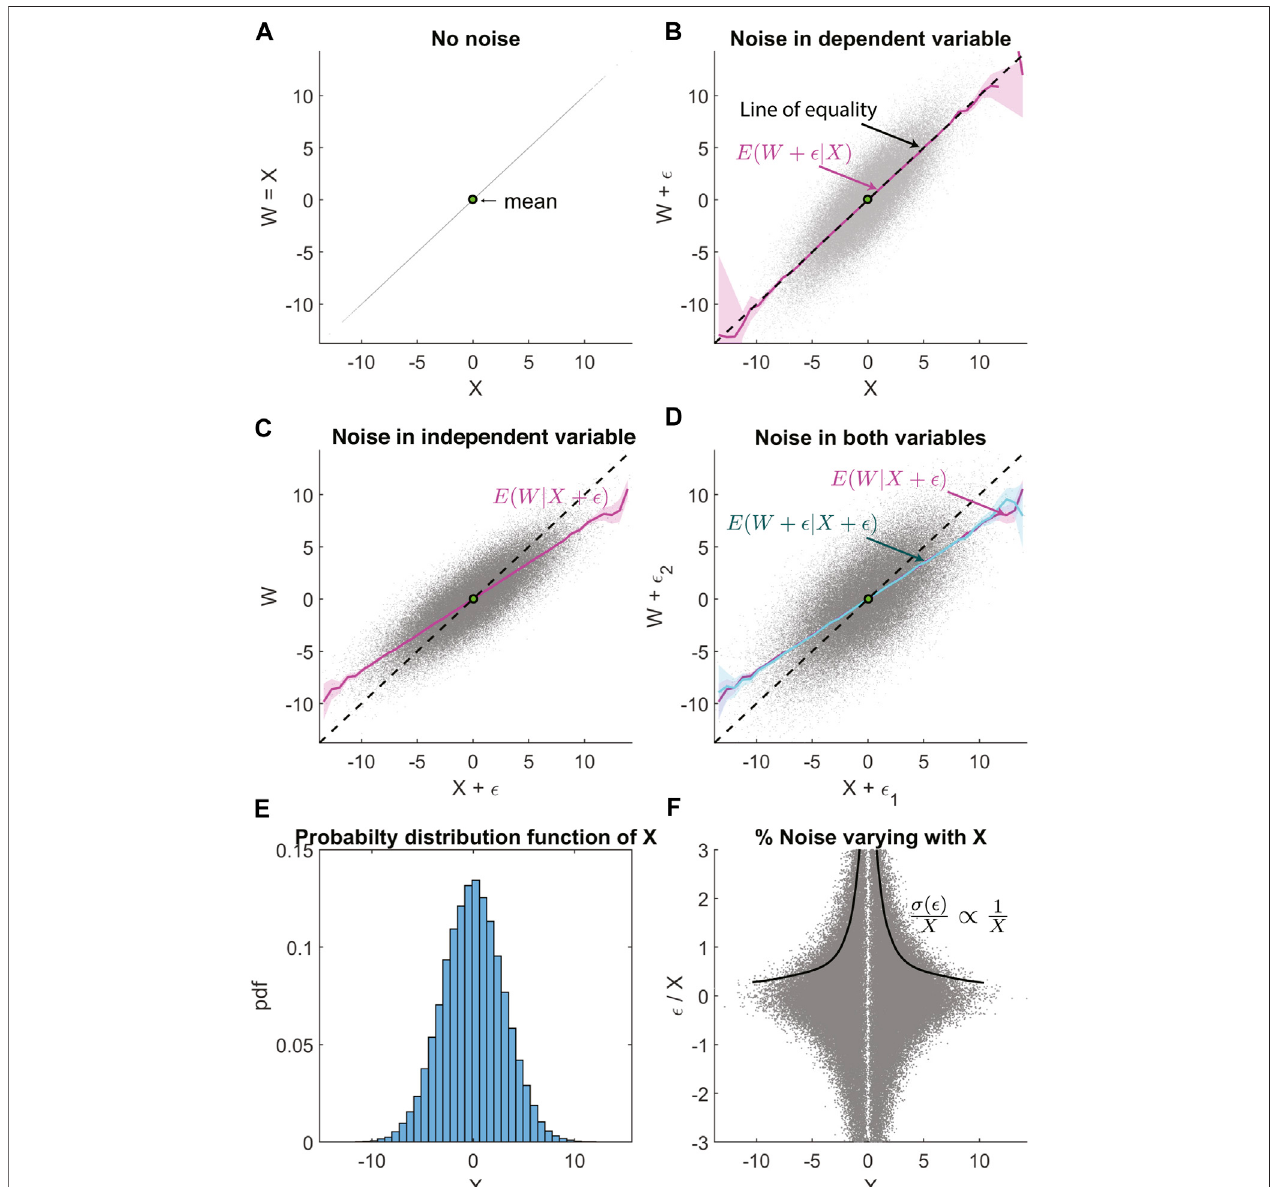
FIGURE1 | Regressionbias in non-linear regression analysis between normally distributed randomvariables,with uncorrelated Gaussiannoise. (A) Scatter plot of W vs. X, where X is anormallydistributed random variable and W =X. (B) Uncorrelated Gaussian noise ϵ isadded to W . Magentaline shows the conditional expectation E ( W + ϵ | X ). The dashed black line is the line of equality. (C) Uncorrelated Gaussian noise added only to X , with the magenta line E ( W | X + ϵ ) showing regression bias. (D) UncorrelatedGaussiannoiseisaddedtoboth W and X ,withregressionbiasin E ( W + ϵ | X + ϵ )isvisibleinthecyanline.Thisoverlapswiththemagentalinethatshows E ( W | X + ϵ )forcomparison. (E) Probabilitydistribution function X showingthenormaldistribution withzeromeanandstandarddeviation3. (F) Thefractionalerror ϵ / X that is varying inversely with X , as σ ( ϵ ) = constant .